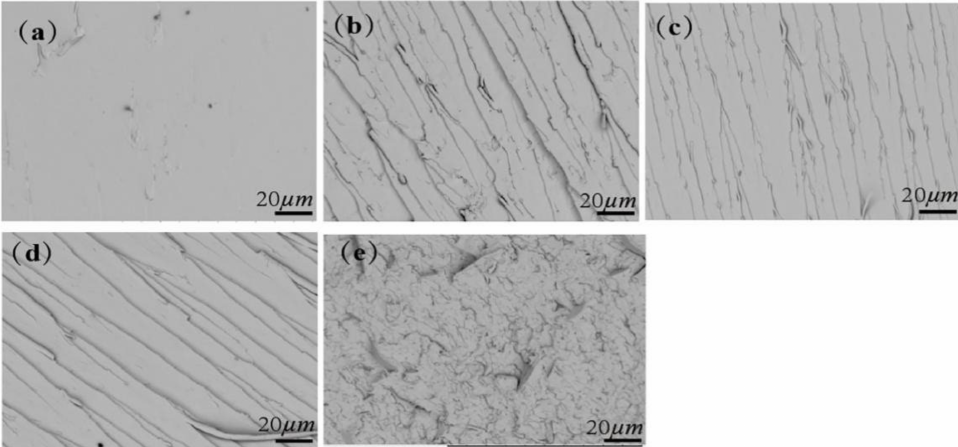
Figure 13. SEM images of fracture surfaces of ( a ) EP, ( b ) EP/PolyTi1, ( c ) EP/PolyTi2, ( d ) EP/PolyTi3, and ( e )